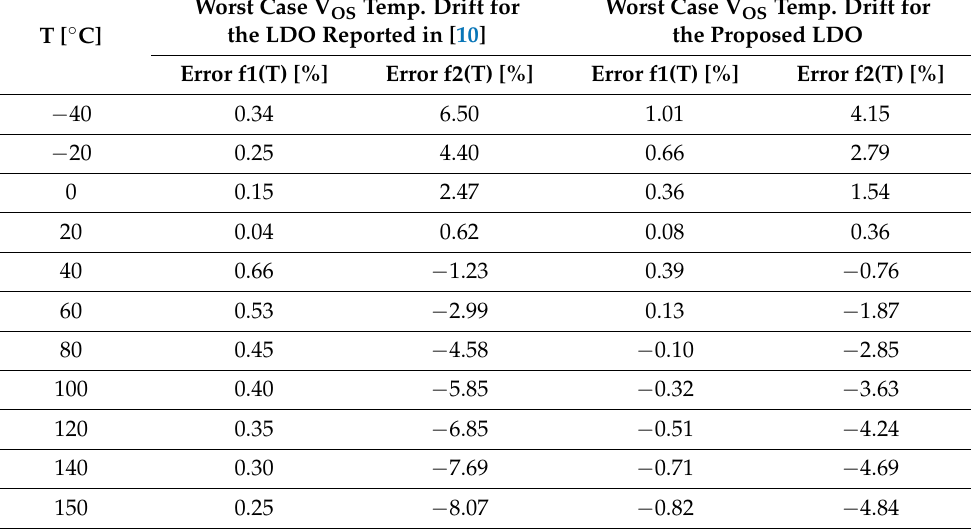
Table 2. Deviation from the ideal-supply case of frequencies provided by oscillators supplied by the LDO reported in [10] and the LDO proposed here, for the Monte Carlo simulation runs that yielded the worst-case V OS temperature drift for each LDO. Worst Case V OS Temp. Drift for Worst Case V OS Temp. Drift for the LDO Reported in [10] the Proposed T [ ◦ C]